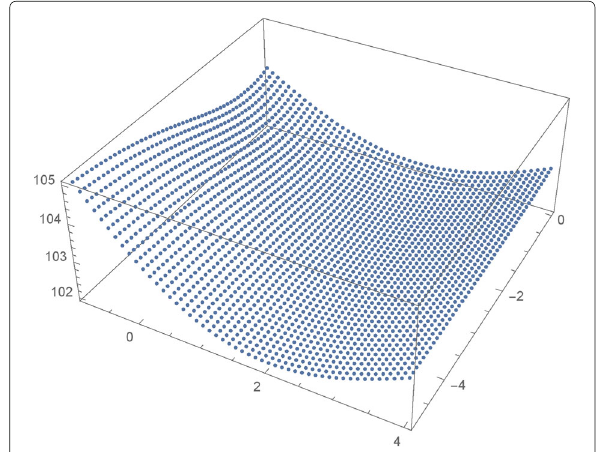
Fig. 15 Expectation value of the procurement cost E [ C ]